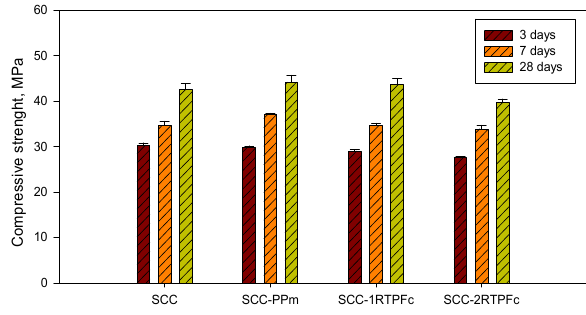
Figure 8. Compressive strength for SCC mixes after 3, 7 and 28 days.